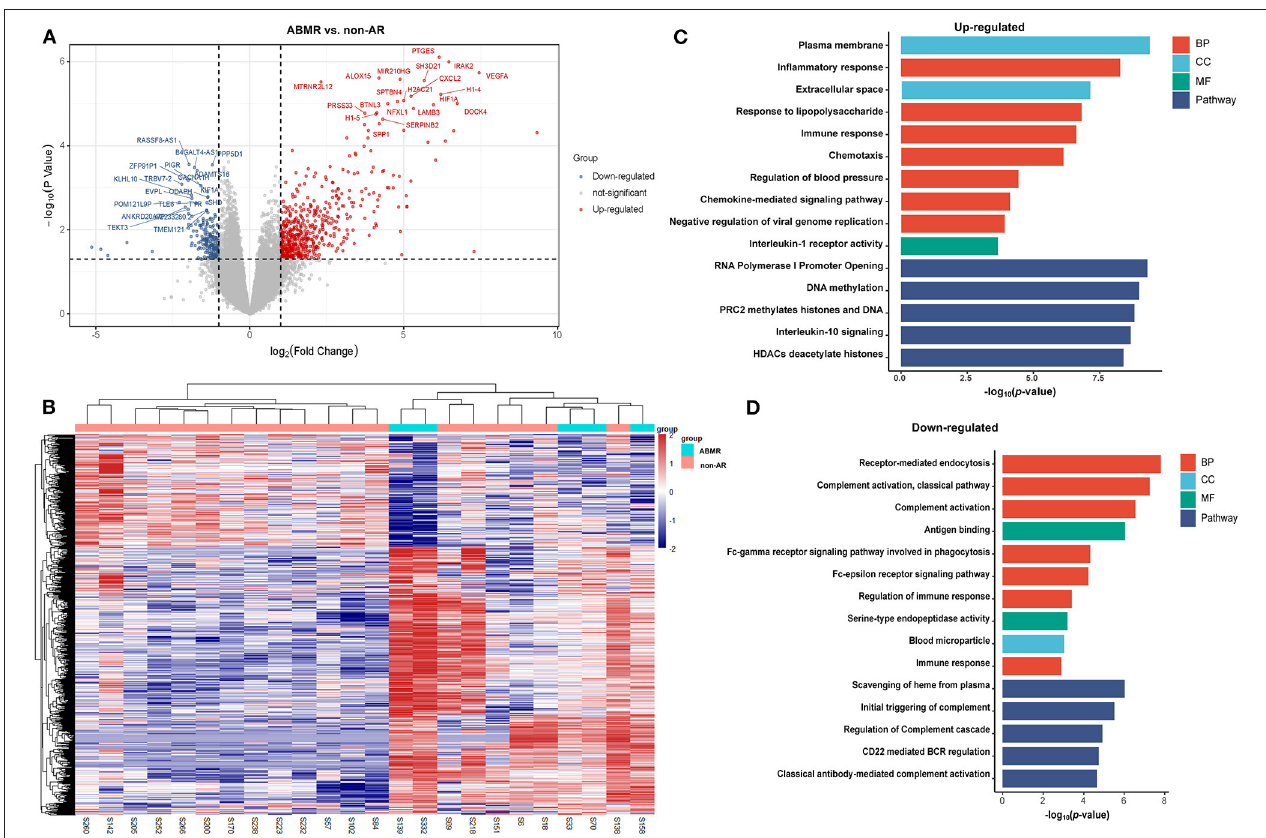
FIGURE 2 | DEGs and GO analysis (ABMR and non-AR recipients). (A) Volcano map of DEGs in ABMR vs. non-AR recipients. Red and blue represent upregulated and downregulated genes, respectively. A total of 1,036 genes were identified as DEGs in PBMCs of patients with ABMR, among which 730 were upregulated and 306 were downregulated. (B) Hierarchical clustering heatmap analysis of DEGs. Red represents upregulated genes, and blue represents downregulated genes. (C) GO and pathway analysis of upregulated DEGs. GOs of inflammatory response and IL-10 signalling were significantly enriched. (D) GO and pathway analysis of downregulated DEGs. GOs of the complement activation and classical antibody-mediated complement activation pathway were significantly